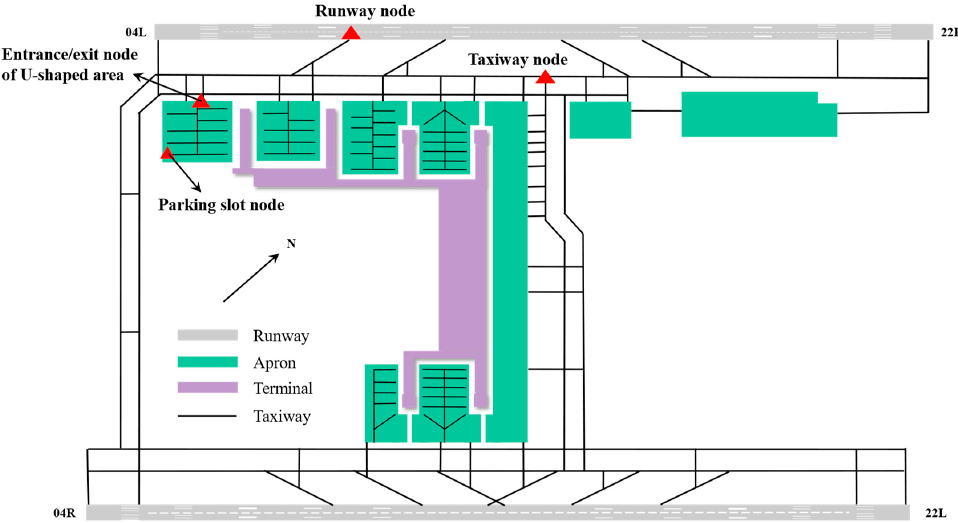
Figure 7. Network and Key Nodes Diagram of Airport Surface. Red triangles indicate the different types of airport surface nodes.